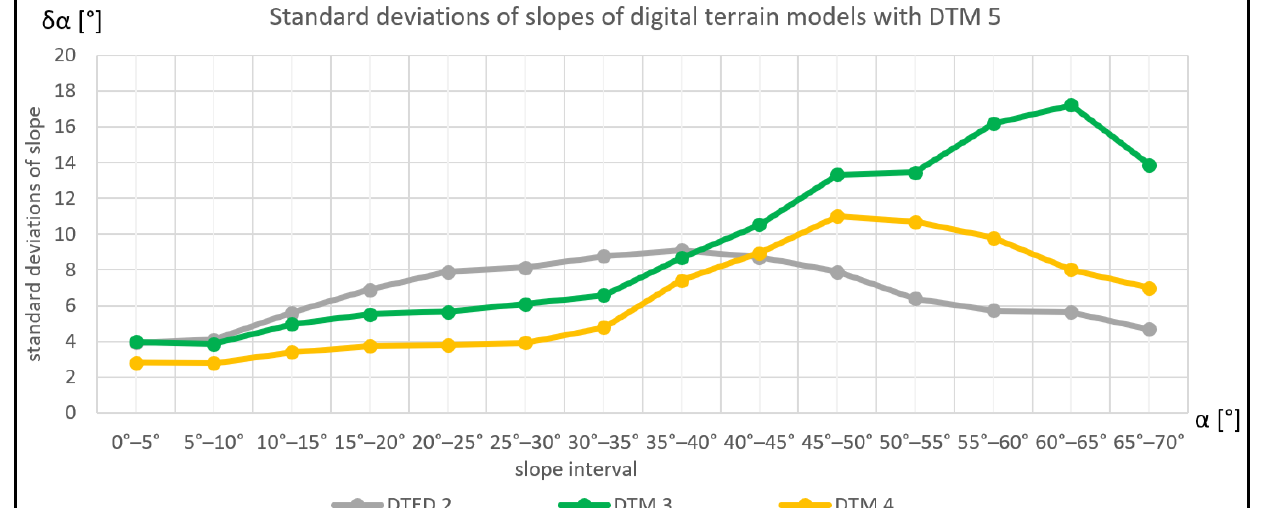
4, DTM 3, DTED 2) at identical points. Slope classes were determined from DTM 5. DTM 3, DTED 2) at identical points. Slope classes were determined from DTM